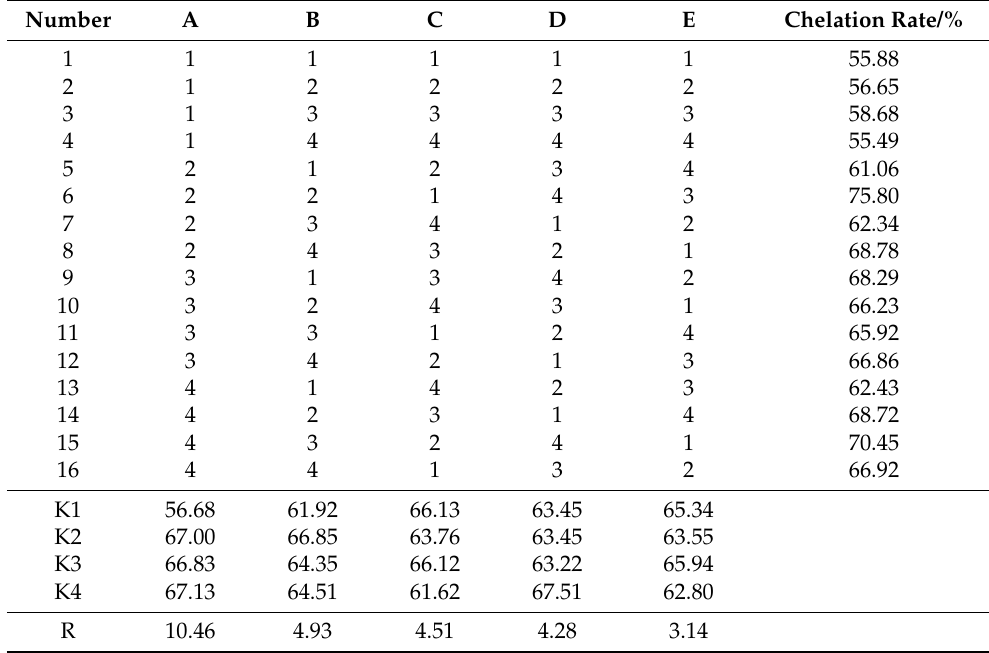
Table 1. Orthogonal test (L 16 (4 5 )) of Gly − chelated Zn production parameters.